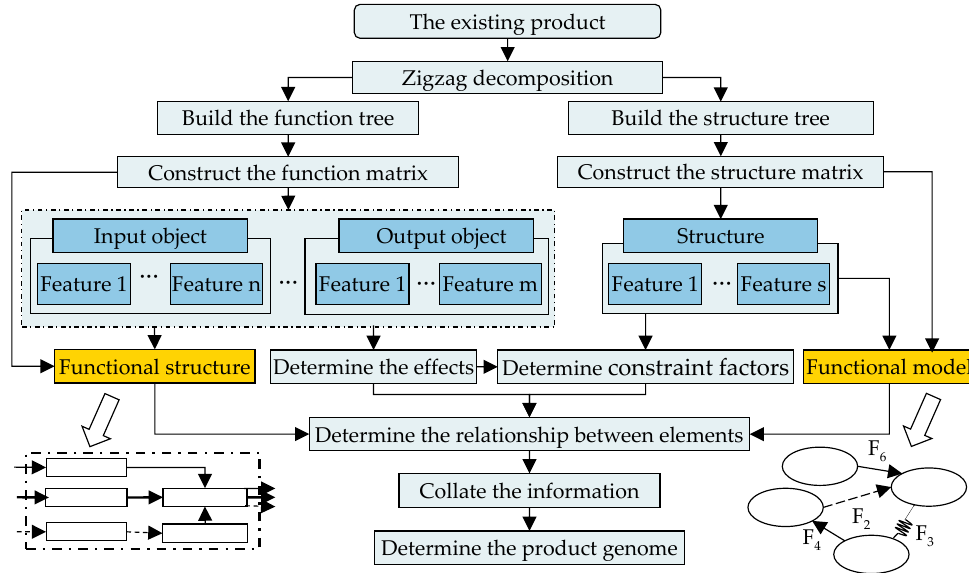
Figure 10. Construction process model of the product genome.